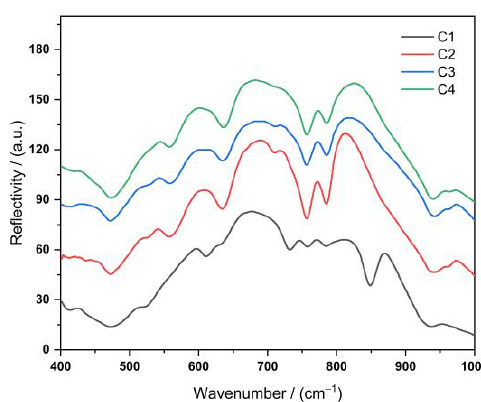
Figure 3. FT-IR spectrum of lithium aluminosilicate glass-ceramics with four different formula- tions.